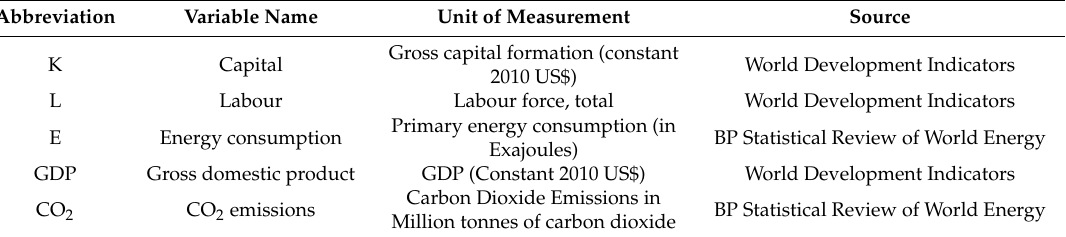
Table 1. Details on indicators for total factor energy e ffi ciency